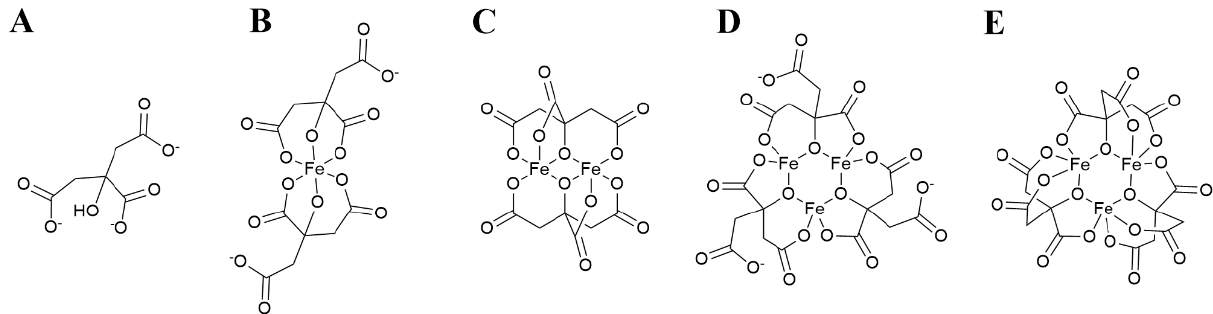
Figure 1. Schematic representation of the structure of citrate and ferric citrate complexes in aqueous solution. ( A ) Citrate anion. ( B ) [FeCit 2 ] 5 − . ( C ) [Fe 2 Cit 2 ] 2 − . ( D ) [Fe 3 Cit 3 ] 3 − . ( E ) alternative structure for [Fe 3 Cit 3 ] 3 − . Structures C, D and E are adapted from Gautier-Luneau et al. [71], structure E has been proposed by Fukushima et al. [75].